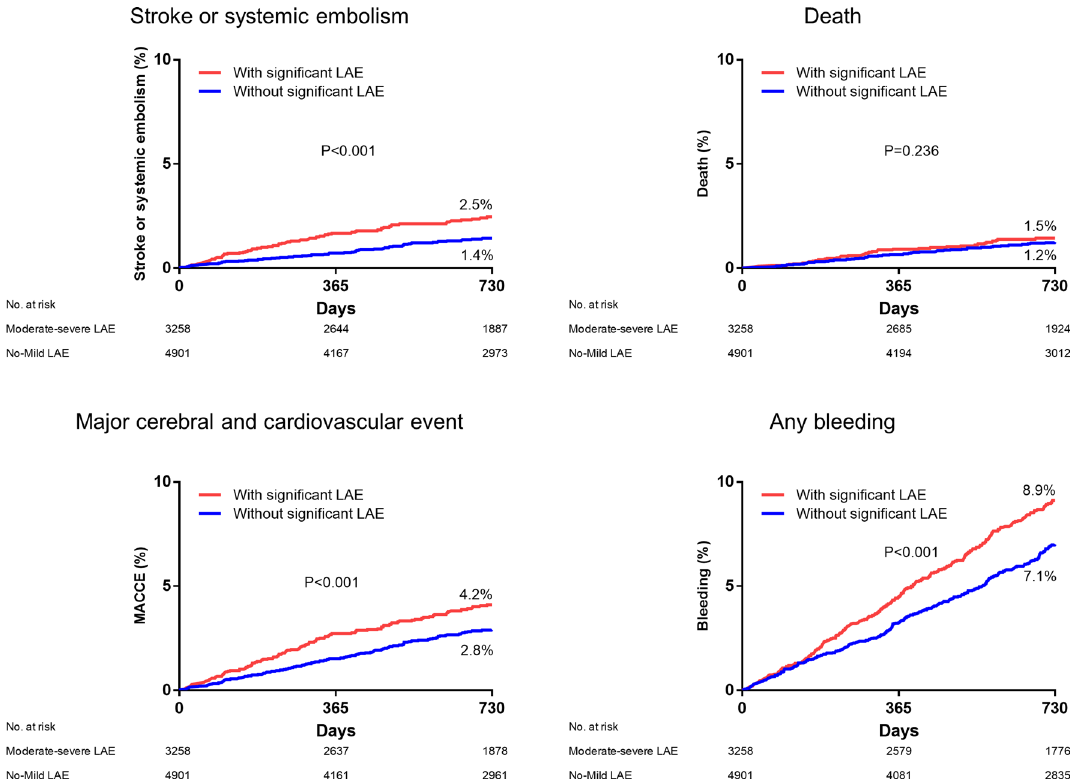
Figure 3. Rate of clinical outcomes according to the presence of moderate–severe left atrial enlargement.